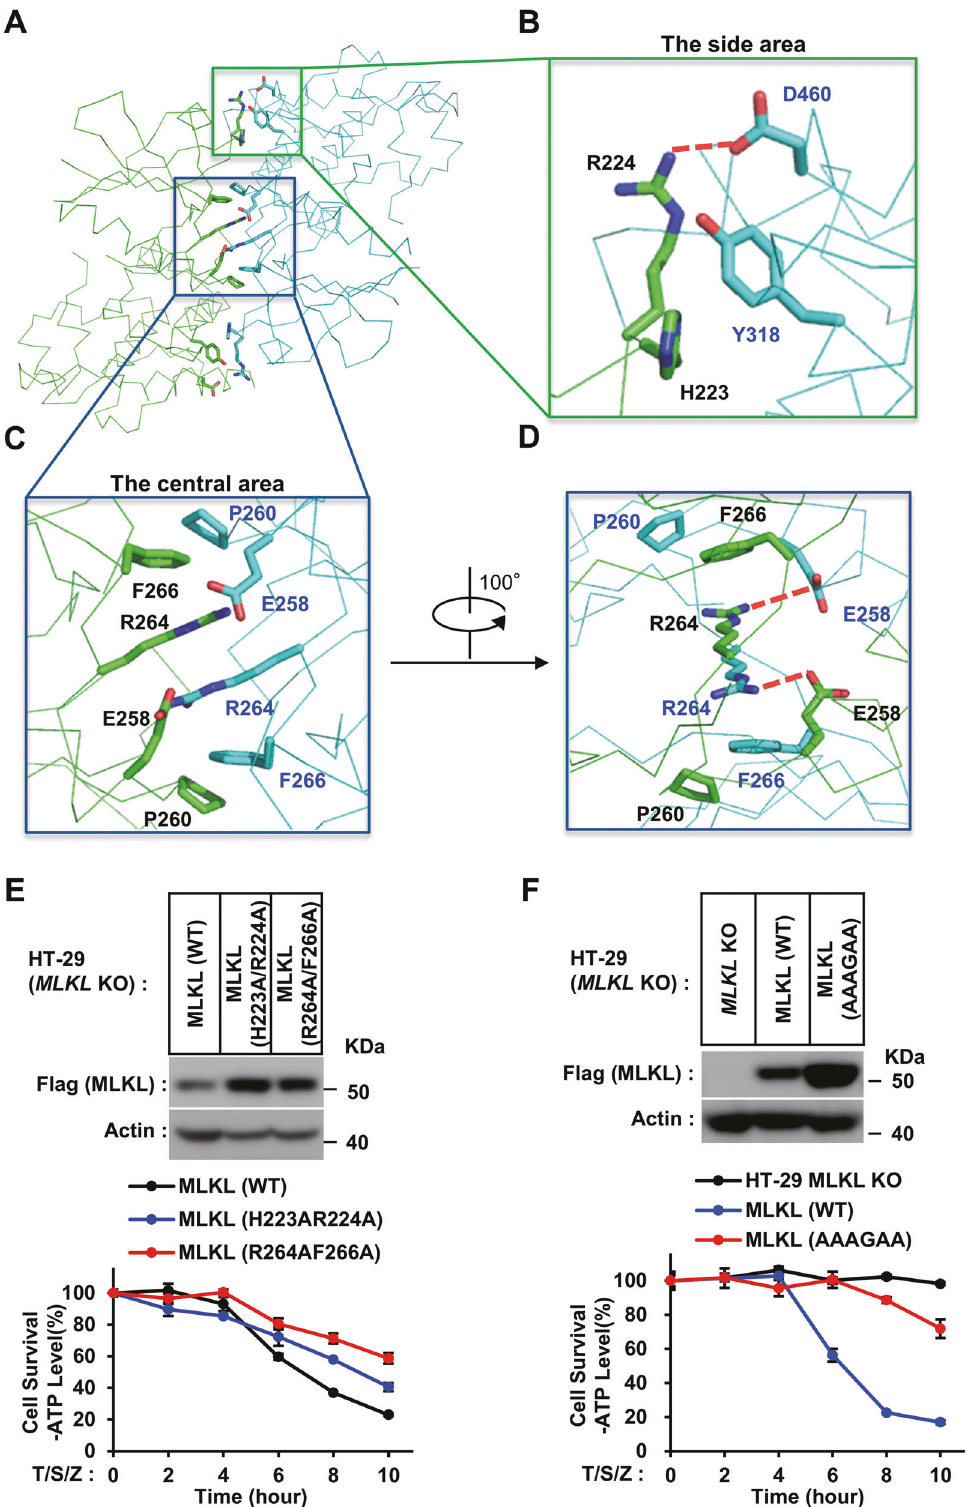
(Fig. S2B). It showed that although, both coiled-coil mutant (4 A) and KLD dimerization mutant (AAAGAA) of MLKL were not sensitive to necroptosis induction (Fig. S2C), they behaved differently on necroptosis-dependent monomer-oligomer transi- tion. The 4 A mutations could only decrease the MLKL